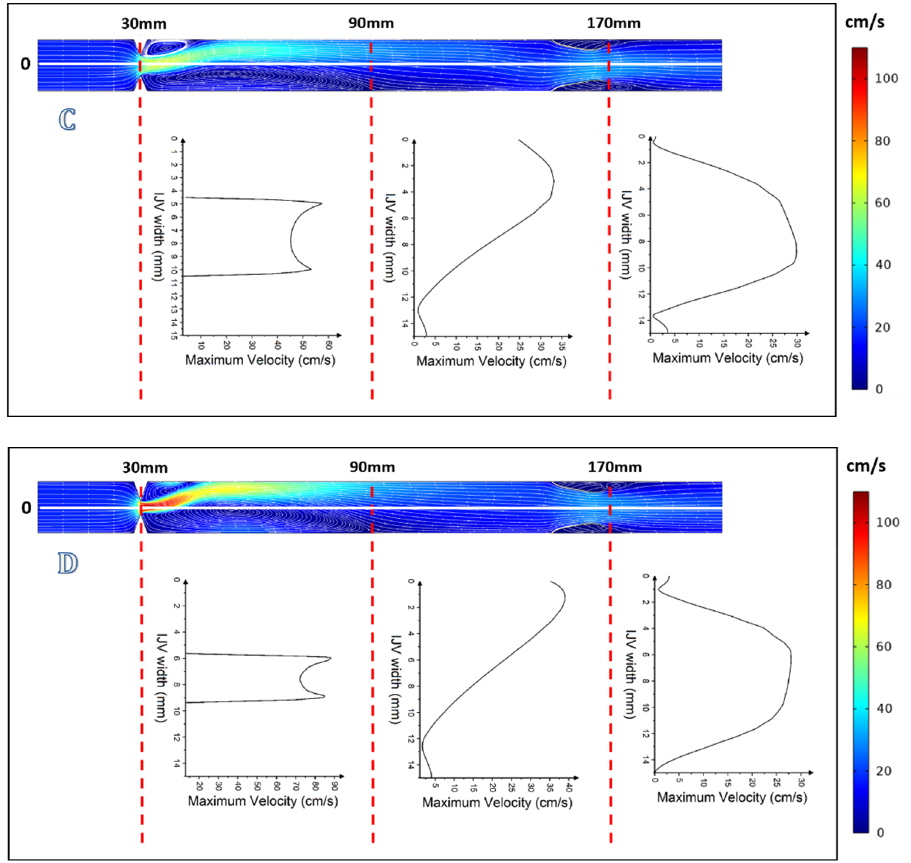
Figure 5. Graphical representation of flow with velocity profiles at t = 1.5 s: ( A ) without upstream stenosis; ( B ) with 30% upstream stenosis; ( C ) with 60% upstream stenosis; and ( D ) with 75% up- stream stenosis.